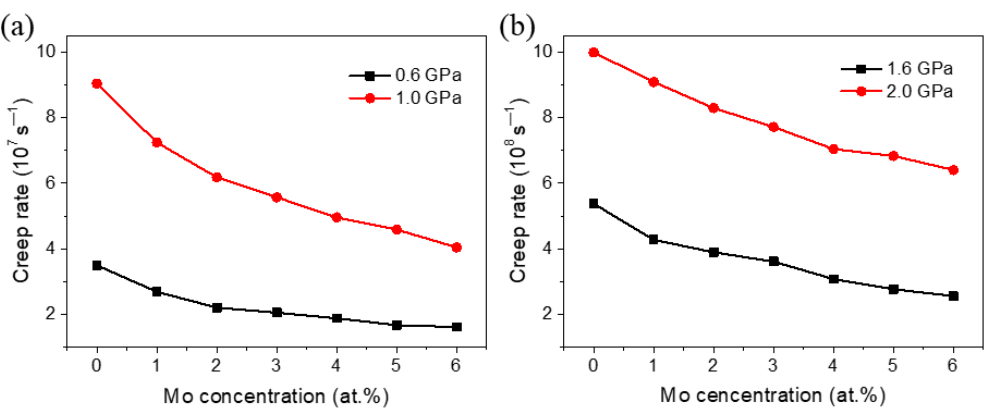
Figure 9. Variation in creep strain rate with the Mo concentration of segregated Ni-Mo samples with d = 10.9 nm under different stresses : ( a ) 0.6 GPa and 1.0 GPa, and ( b ) 1.6 GPa and 2.0 GPa.